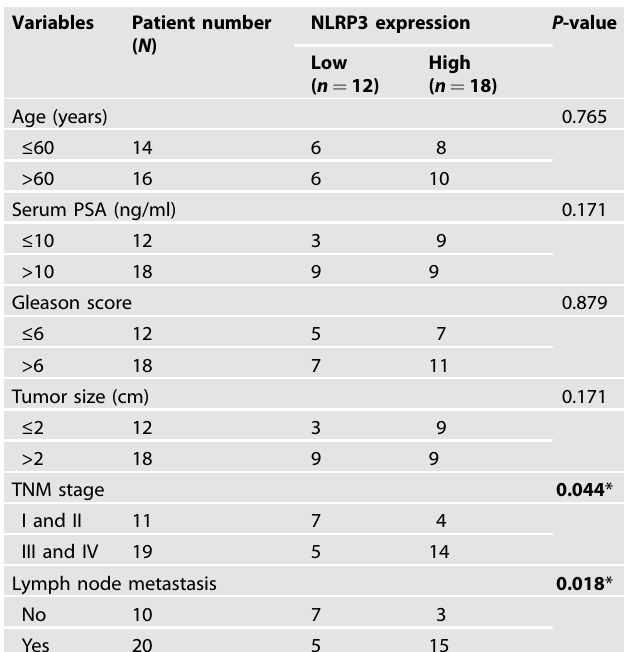
Table 1. Association of NLRP3 expression with clinicopathologic characteristics of prostate